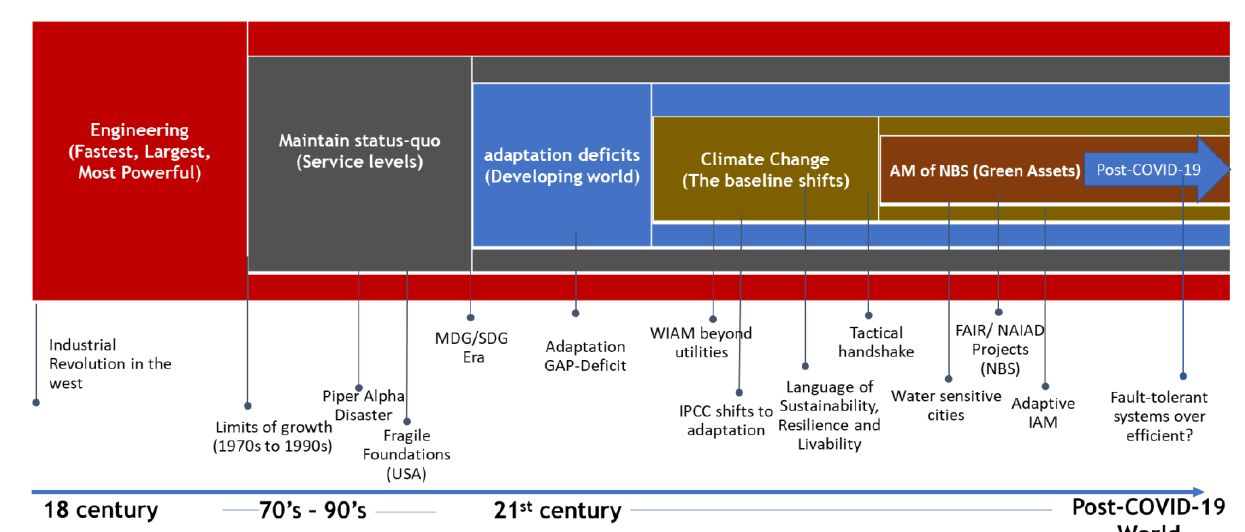
Figure 1. A timeline of the development of Water Infrastructure Asset Management.